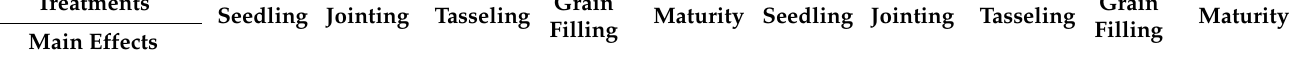
Table 3. Interactive impact of straw mulch and biochar application rates on the leaf number of the maize crop.